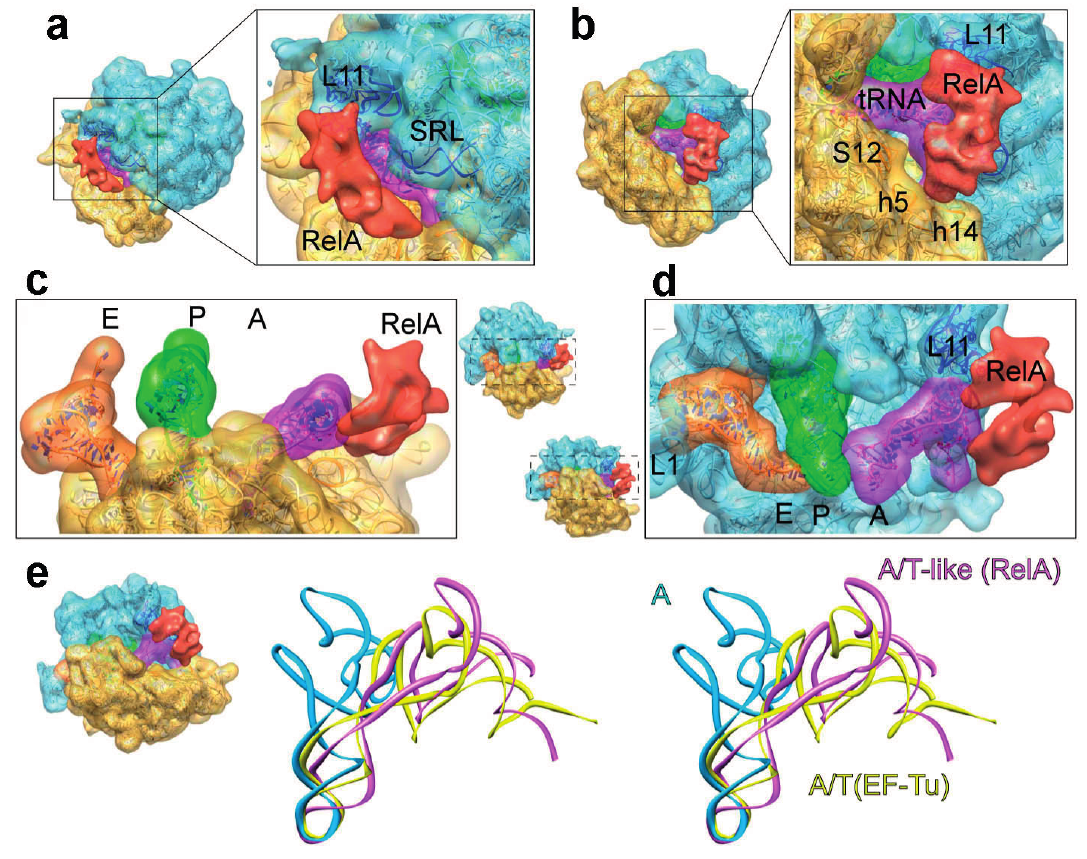
Figure 9. Sensing amino acid starvation. ( a – d ) 3D cryo-EM structure of the 70S–RelA complex. The molecular structures fitted to the density are shown in ribbons; ( e ) Stereo-view of the superposition of the A/T state tRNA in the presence of EF-Tu (PDB 4V5G [129]), the classic state A/A tRNA (PDB 4V5D [133]) and the A/T-like structure in the presence of RelA. (Figure adapted from [207], Copyright 2013 John Wiley &